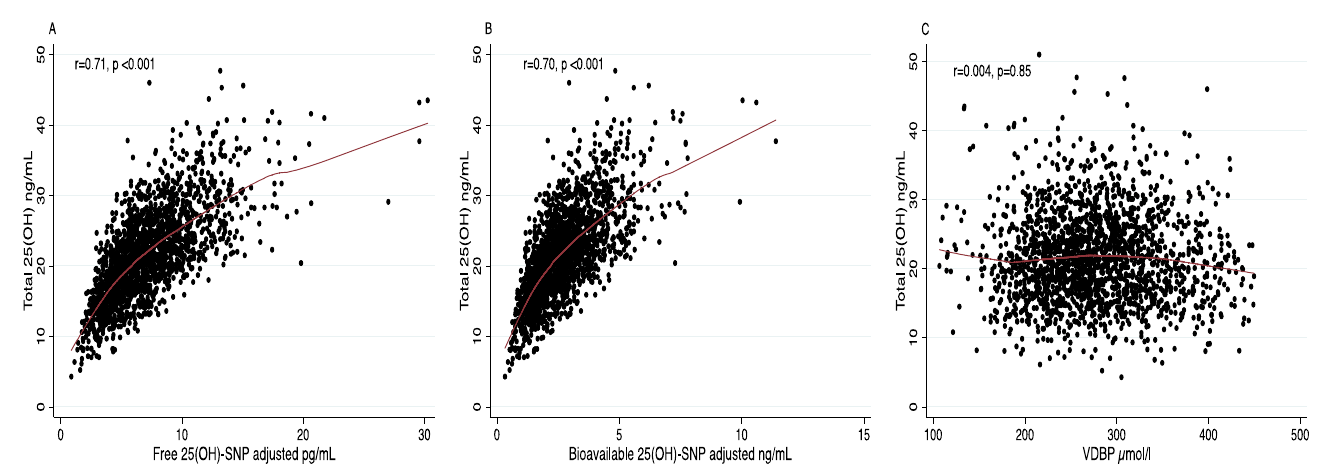
Figure 1. Scatter plot representation of the correlation between total 25(OH)D with free 25(OH)D ( A ), bioavailable 25(OH)D ( B ) and VDBP ( C ) in 1904 subjects from the Health Workers Cohort Study.